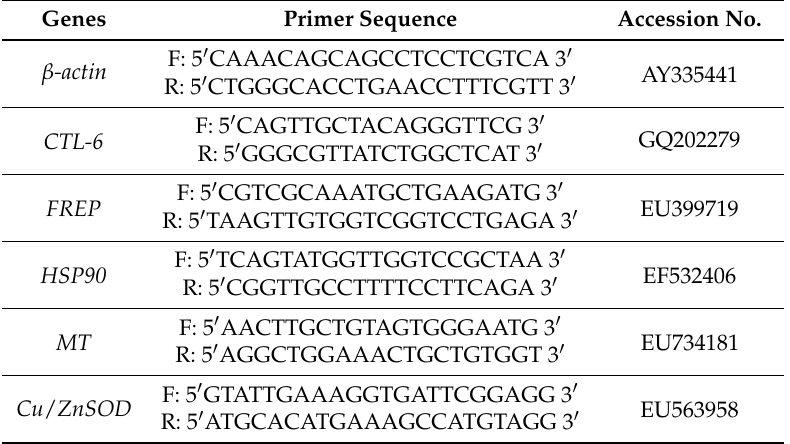
Table 1. Primers used for the analysis of mRNA expression by qRT-PCR. Genes Primer Sequence Accession